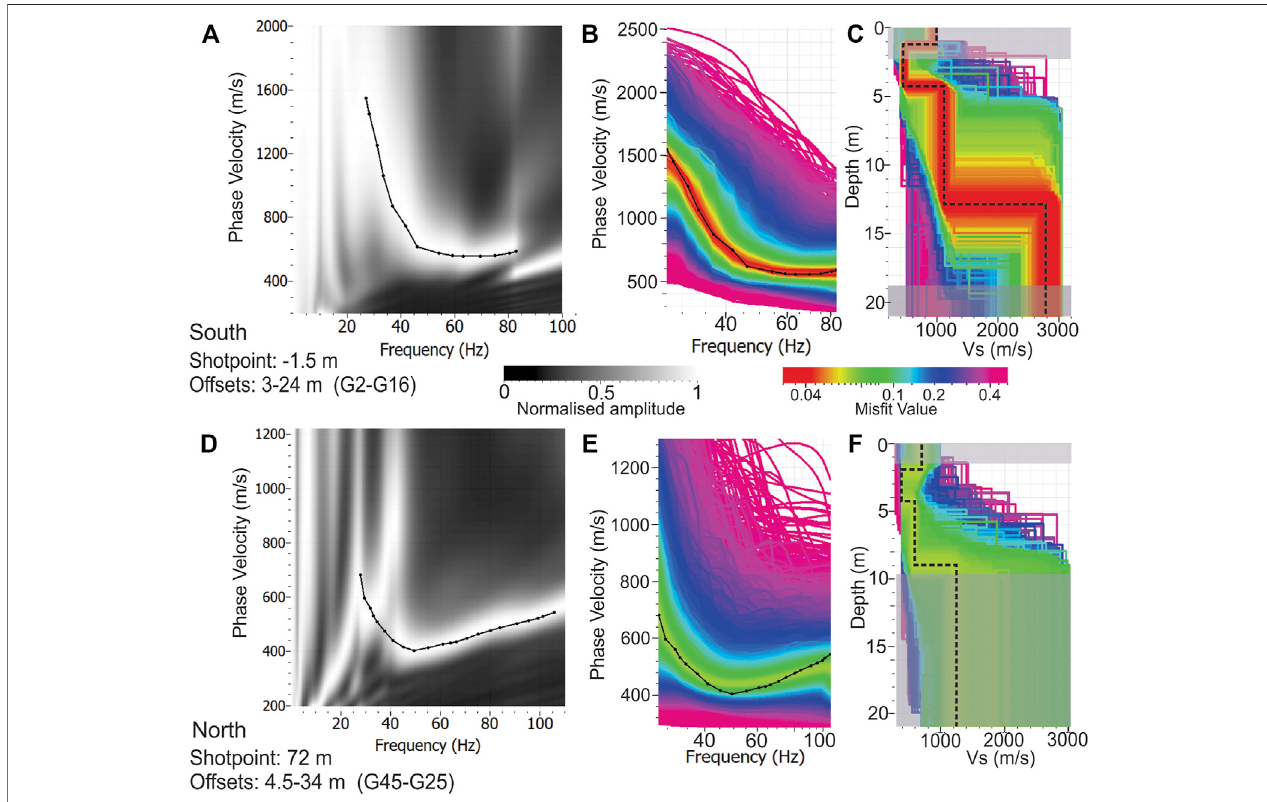
FIGURE4| MASWdispersioncurvesandinversionresultsfromtheLateralMoraineSite: (A – C) usegeophonesG2toG16andthesouthernshotpoint,at − 1.5 m, and (D – F) use geophones G 45 to G 25 and the northern shotpoint, at 72 m. Picked dispersion curves for each site are shown in A & D. All modelled dispersion curves tested in the inversion are shown in B & E, with corresponding mis fi ts plotted as the colour scale, high mis fi t models progressively overlain by lower mis fi t models, and picked valuesdisplayed inblack.C&Fshowall v s pro fi lesassociatedwiththemodelleddispersioncurvesandcorrespondingmis fi ts,withminimummis fi t v s pro fi le (black dashed line). The grey regions in C & F show approximate resolution limits de fi ned by Z min and Z max ( Table 1